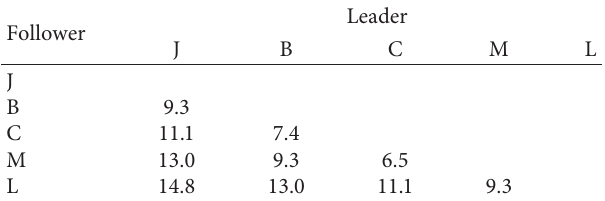
Table 8: Effect of headwind on a distance separation.